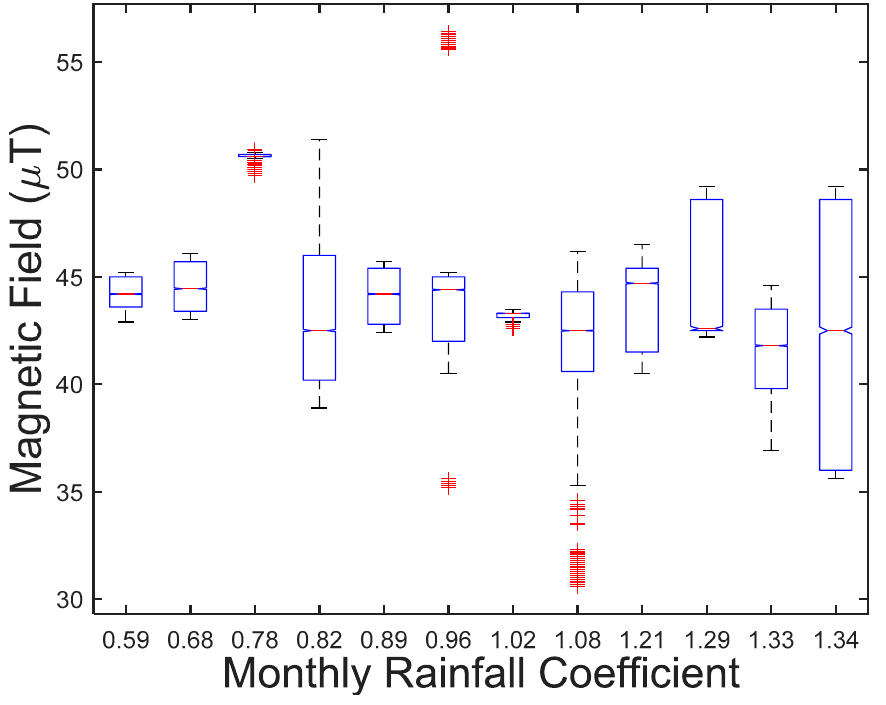
Figure 11. Monthly rainfall coefficient.